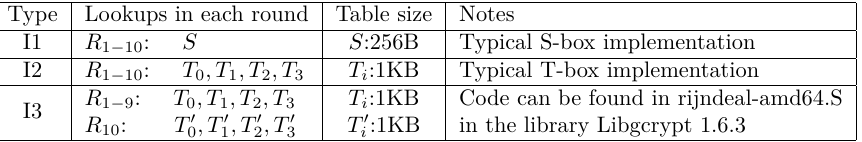
Table 1: Different implementations of AES-128